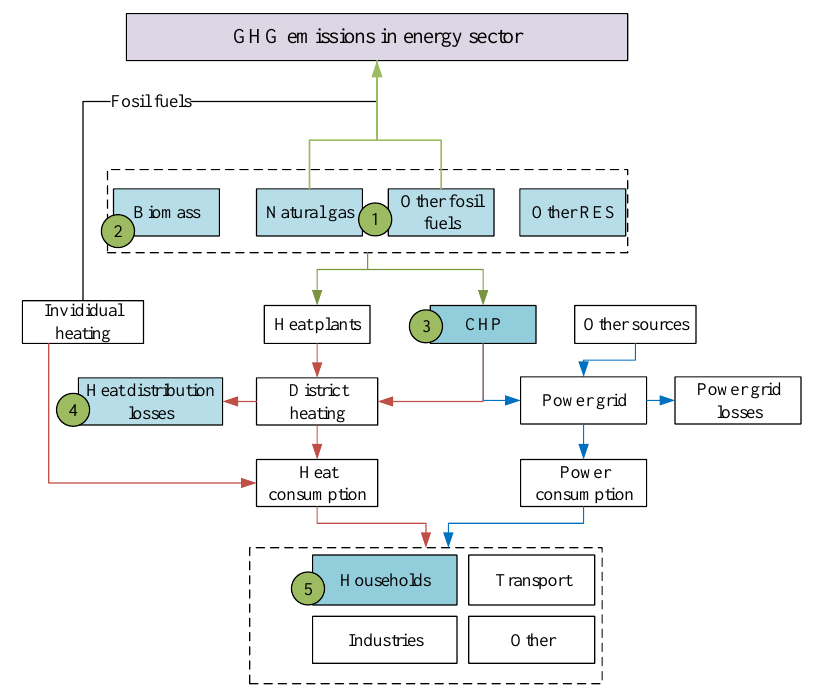
Fig. 1. Energy sector scheme in Latvia and processes affected by 4GDH